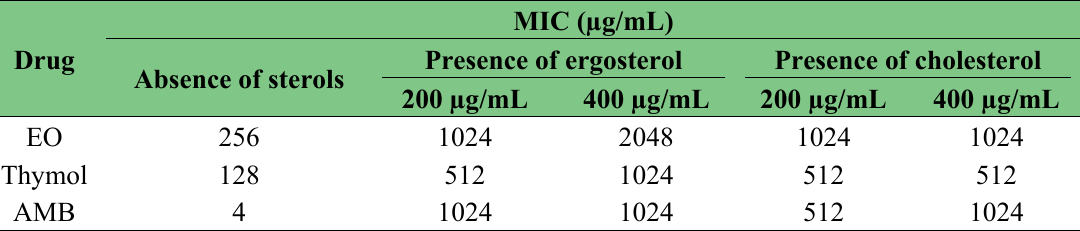
Table 5. Effect of EO of T. vulgaris , thymol and amphotericin B against R. oryzae (RO-4557) in absence and presence of